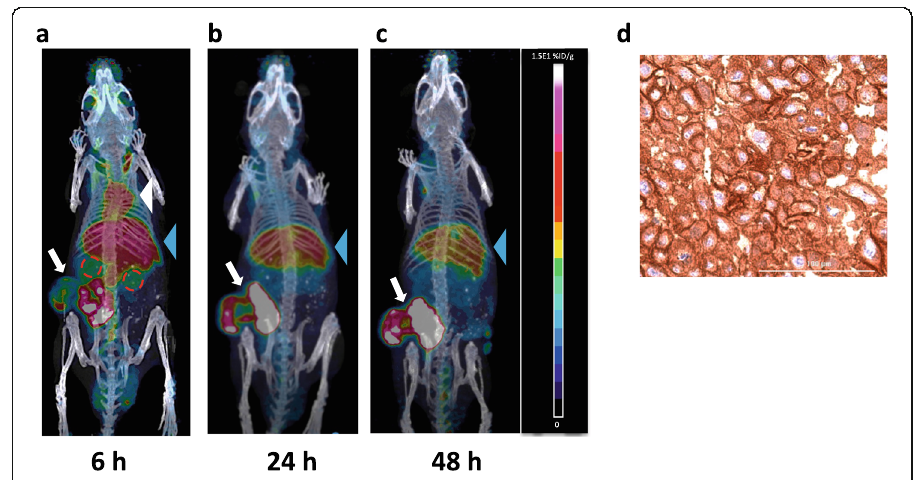
Fig. 3 Posterior whole-body coronal microPET/CT images of a NRG mouse bearing s.c. implanted HNSCC PDX at a. 6 h, b. 24 h or c. 48 h p.i. of [ 64 Cu]Cu-DOTA-panitumumab F(ab´) 2 . The tumour is shown by the white arrow. At 6 h p.i., the mediastinum (blood pool; white arrowhead), liver (blue arrowhead) and kidneys (broken red circles) are visualized, while at 24 and 48 h p.i., the liver was the only normal organ